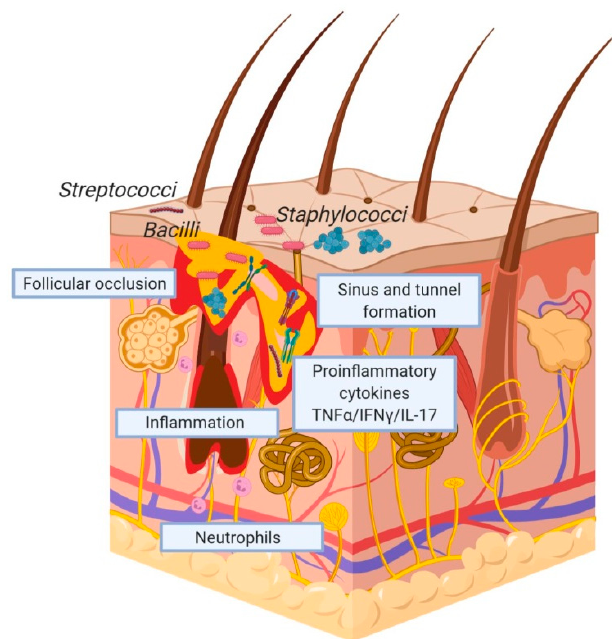
Figure 2. Hidradenitis suppurativa pathogenesis. Inflammation, follicular occlusion, neutrophilic infiltration and a pro-inflammatory cytokine milieu. Microbial colonisation is shown. It remains unclear whether the colonisation results from the disease or contributes to its pathophysiology. The figure was made in ©BioRender—biorender.com.